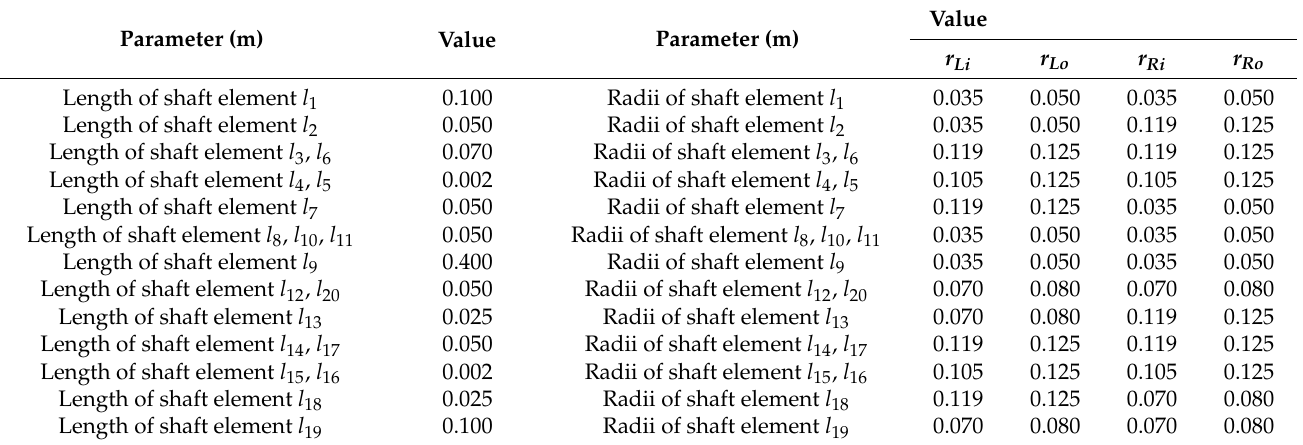
Table A1. Dimensions of the dual-rotor system.